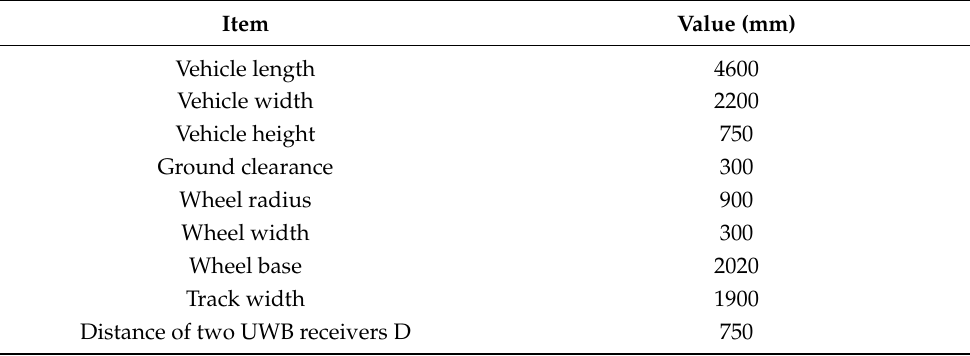
Table 1. Technical parameters of WLR-5A mining wheeled unmanned chassis.